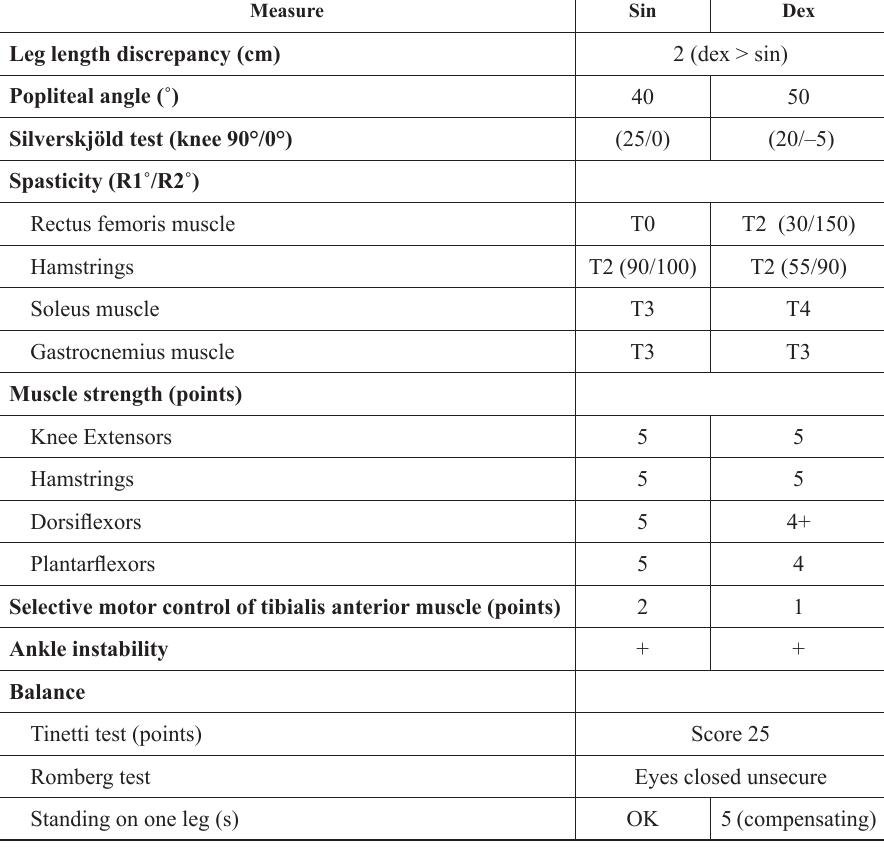
Table 1. Data of patient’s